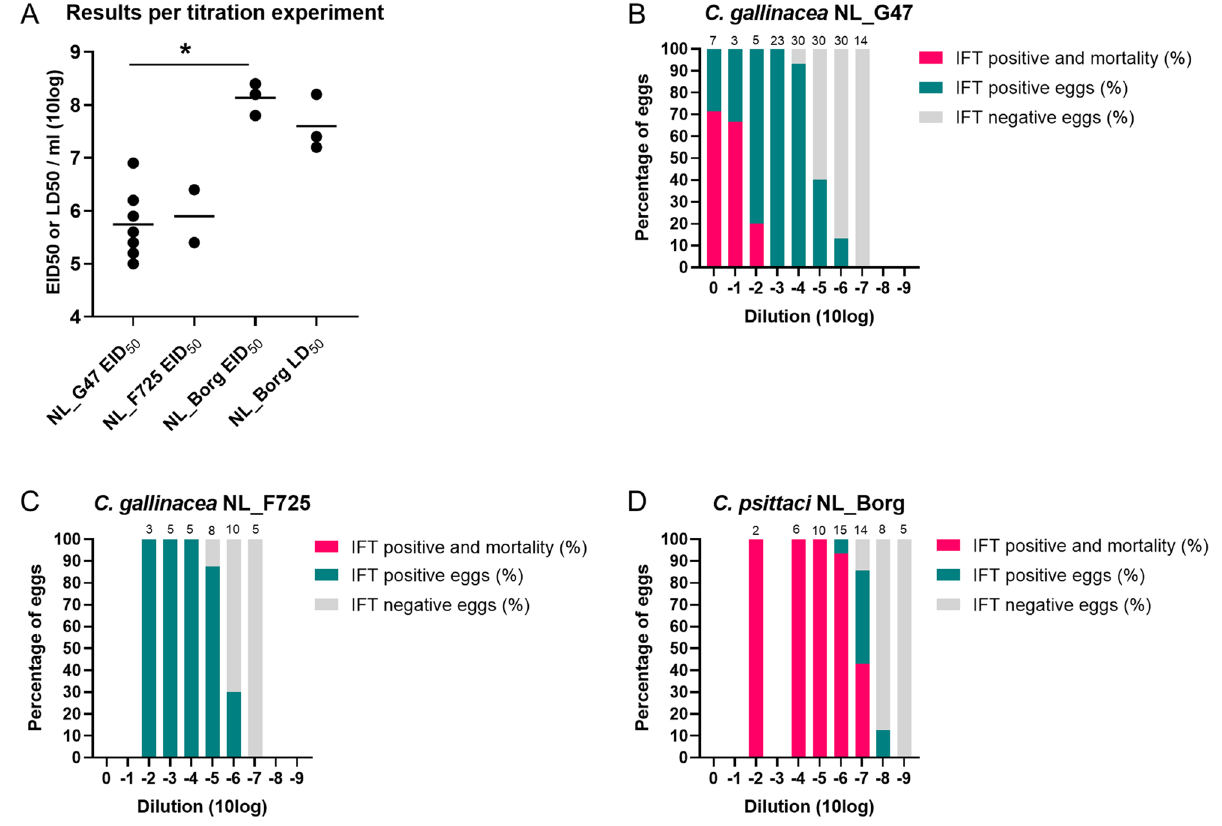
Figure 2. Assessment of virulence of C. gallinacea in embryonated eggs. ( A ) The 50% egg infective dose 50 (EID 50 ) of C. gallinacea NL_G47, NL_F725 and C. psittaci NL_Borg based on IFT of the yolk sac. The difference between EID 50 of NL_G47 and NL_Borg was significantly different (*, P < 0.05, Wilcoxon–Mann– Whitney test). For C. psittaci NL_Borg the 50% lethal dose (LD 50 ) was also calculated. The median EID 50 or LD 50 of the experiments is indicated with a bar. ( B – D ) Depict the cumulative results of the separate titration experiments per Chlamydia strain. Per dilution, the percentage of eggs that was positive for Chlamydia in the immunofluorescence test (IFT) with mortality, IFT positive without mortality and IFT negative are shown. The total number of eggs per dilution are presented at the top of every bar. These data are also included in Supplementary Table S1. The figure was created in GraphPad Prism